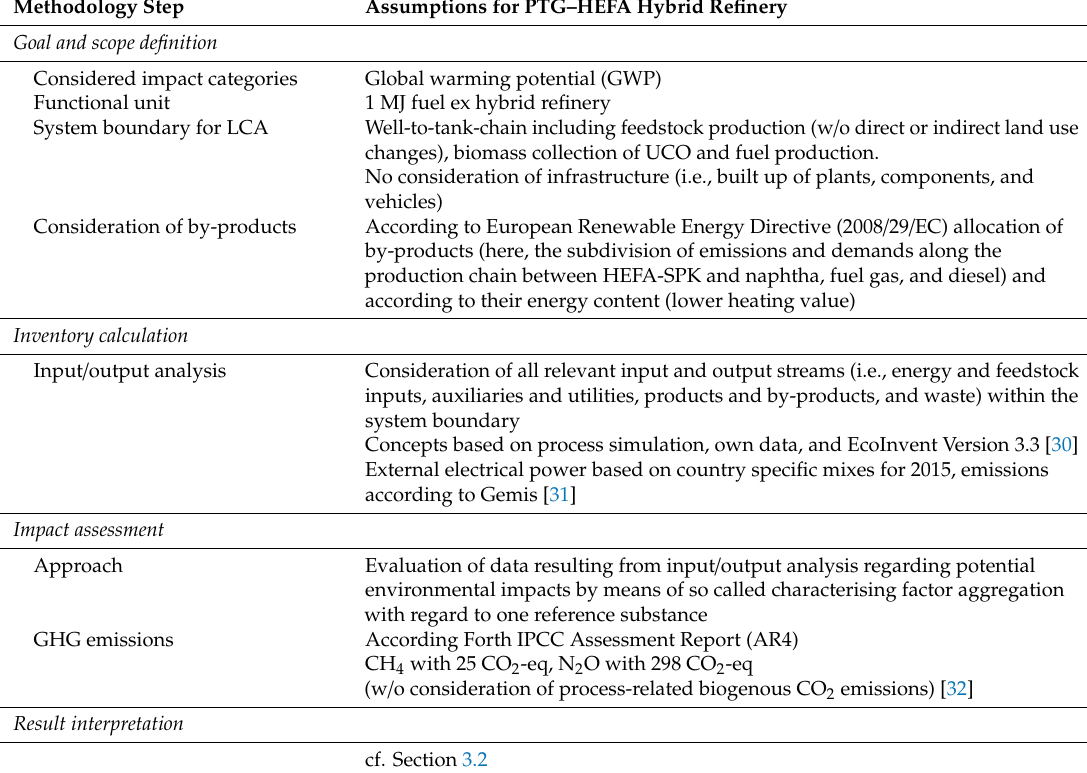
Table 2. Methodology and assumptions for life cycle assessment